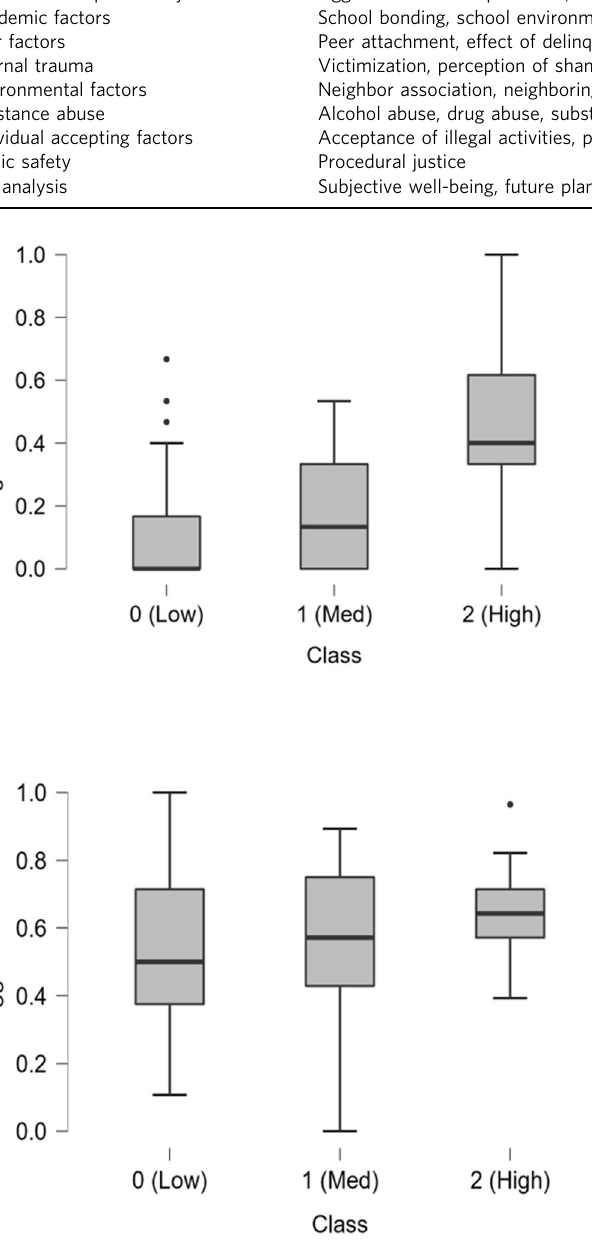
Fig. 3 The box plots of two major attributes viz. neighbourhood association and aggression. X -axis indicates the 3 classes and Y-axis indicates the given